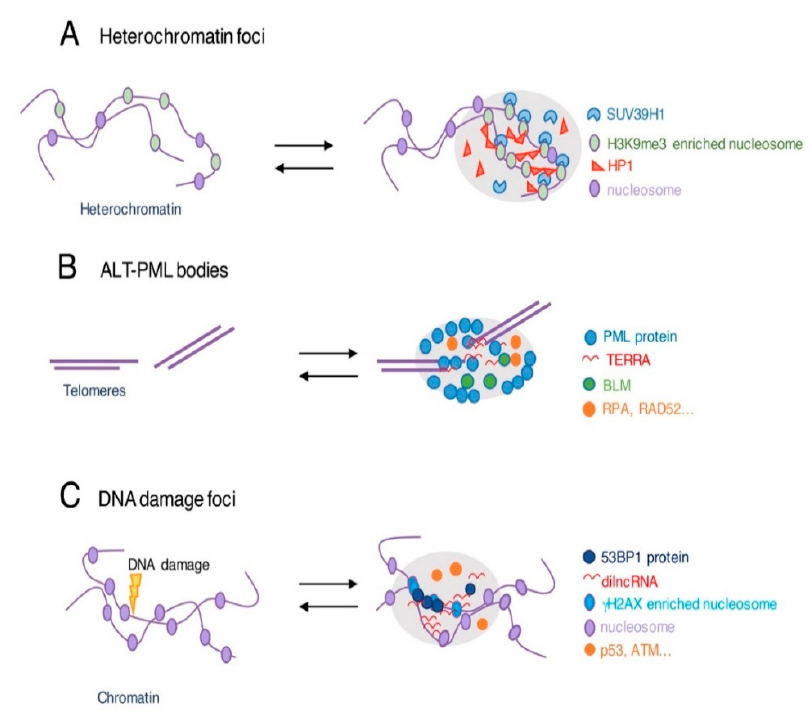
Figure 3. Examples of LLPS condensates in the nucleus. ( A ) LLPS based heterochromatin organization acts at chromatin regions enriched in H3K9me3 histone modifications (green) bound by proteins containing chromodomains, such as HP1 (red) and SUVAR39H1 (light blue), increasing the compaction of the chromatin. ( B ) ALT-associated PML bodies (APBs) are formed by LLPS clustering telomeres (purple), PML protein (blue), and other factors such as BLM (green), DNA damage response proteins (orange), and the long non-coding RNA associated with telomeres, (TERRA; red). ( C ) At site of DNA damage, foci are promoted by 53BP1 (blue) and by the long non-coding RNAs (dilncRNA; red), which increases the concentration of DNA damage response proteins (orange) such as p53.